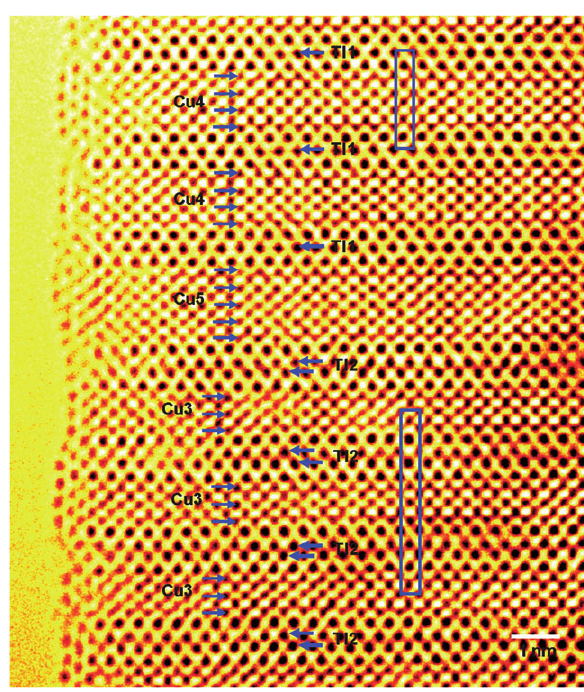
layers and various numbers of Cu-O layers. Upper and lower rect- angles are TlBa